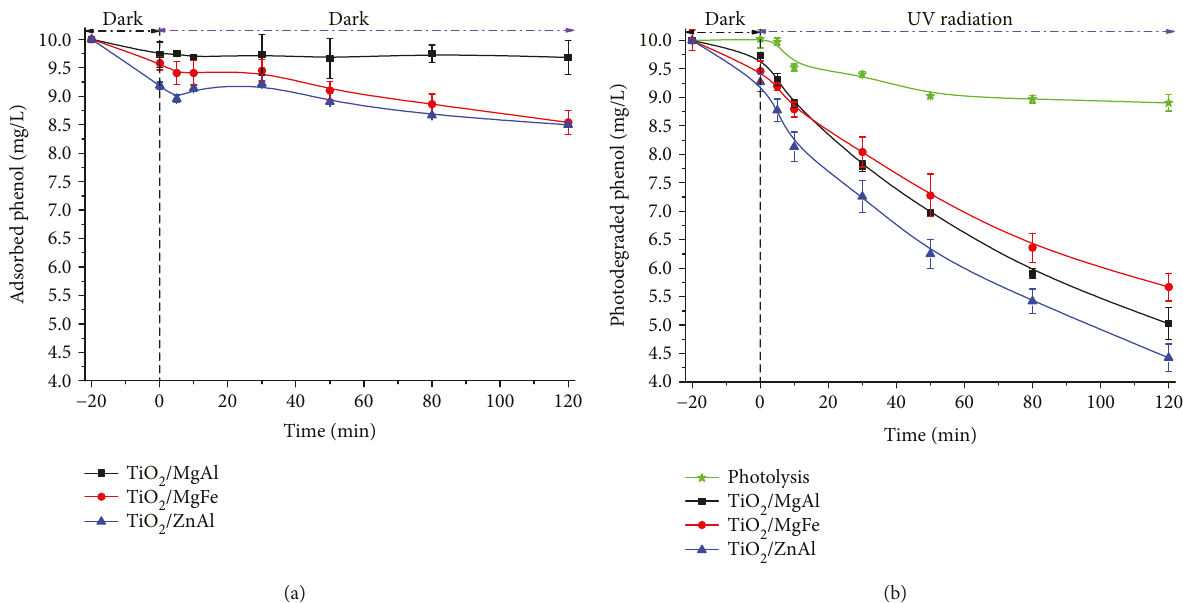
Figure 7: Phenol adsorption and photodegradation with TiO